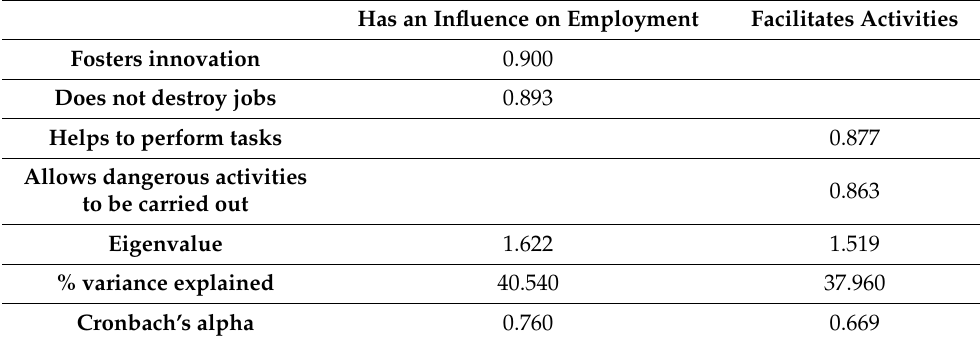
Table 2. Factor analysis